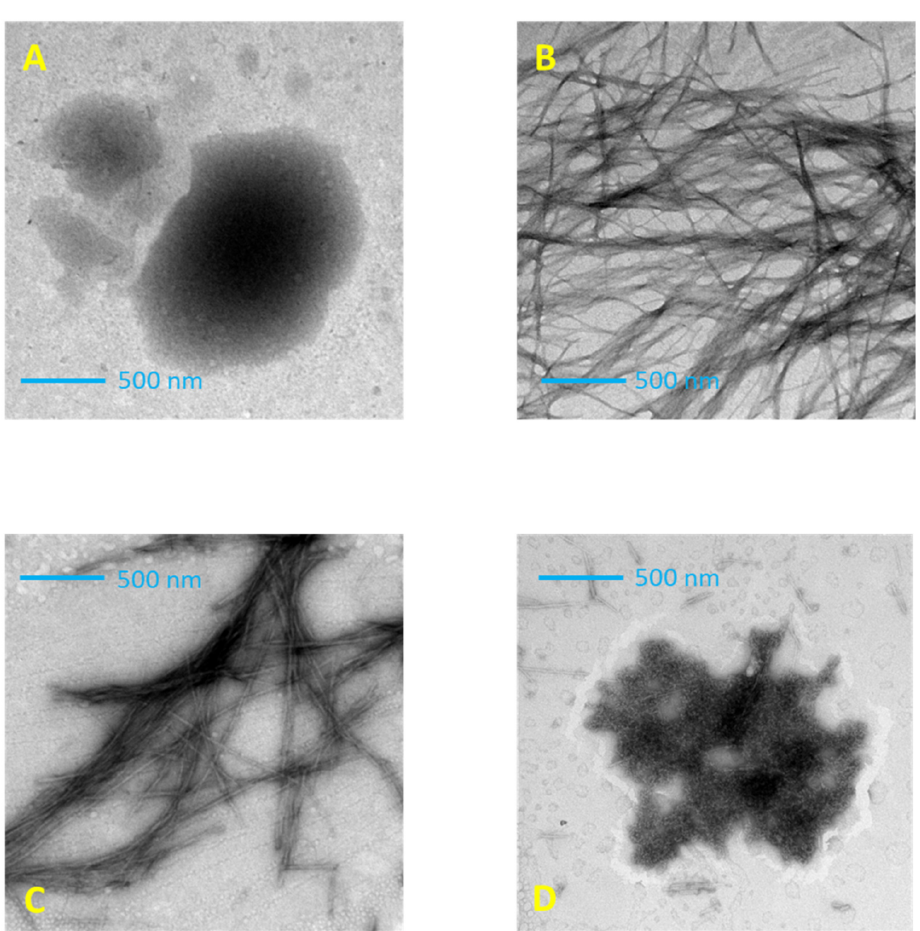
Figure 6. Transmission electron microscopy (TEM) imaging of tau peptide (70.9 µ M) in 10 mM TRIS-HCl buffer, pH 7.4 after 7 h incubation at 25 ◦ C. ( A ) Tau peptide alone; ( B ) in presence of 0.25 molar equivalents of low-molecular-weight heparin; ( C ) in presence of 0.25 molar equivalents of heparin and 6 molar equivalents of ceftriaxone; ( D ) in presence of 0.25 molar equivalents of heparin and 6 molar equivalents of